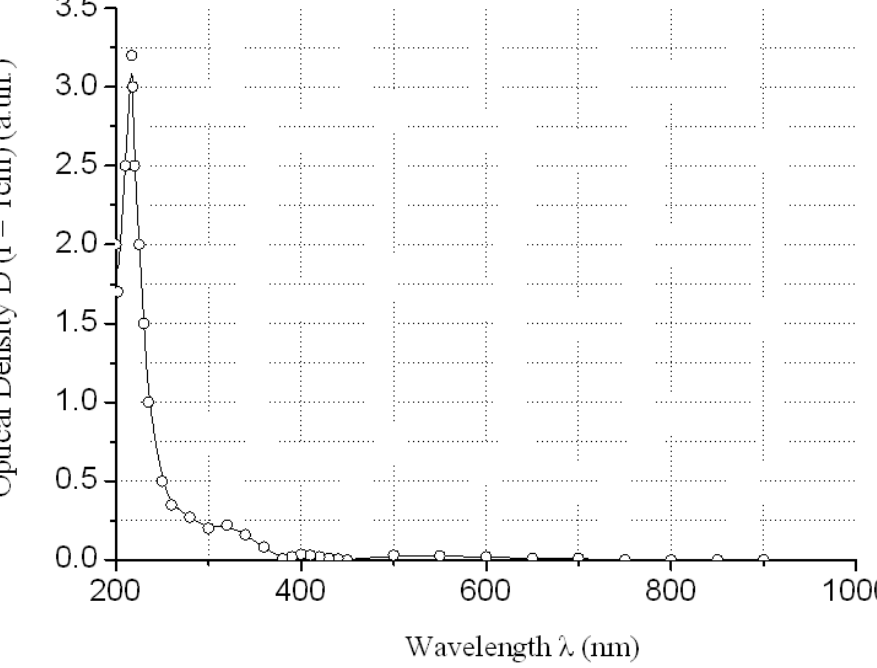
Figure 5. Electronic spectrum of water solution of TbCl 3 at concentration C TbCl3 ≈ 21.3 g/dm 3 relatively distilled H 2 O.